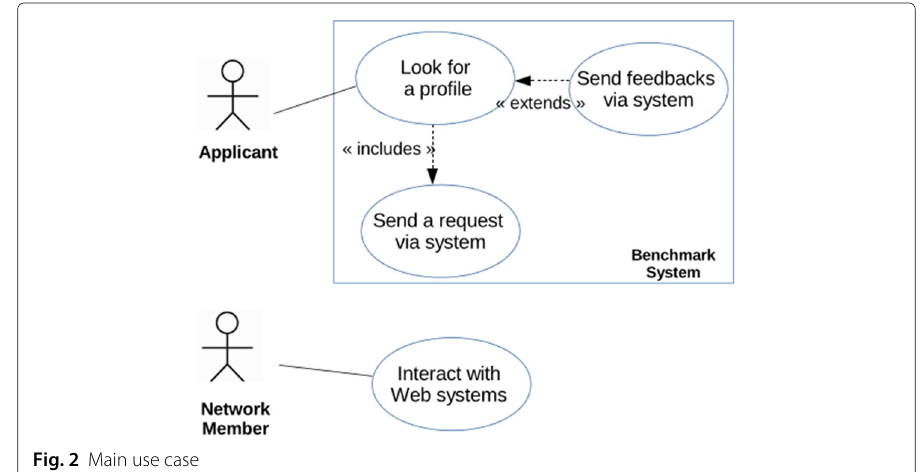
Fig. 2 Main use case Model and experimental platform